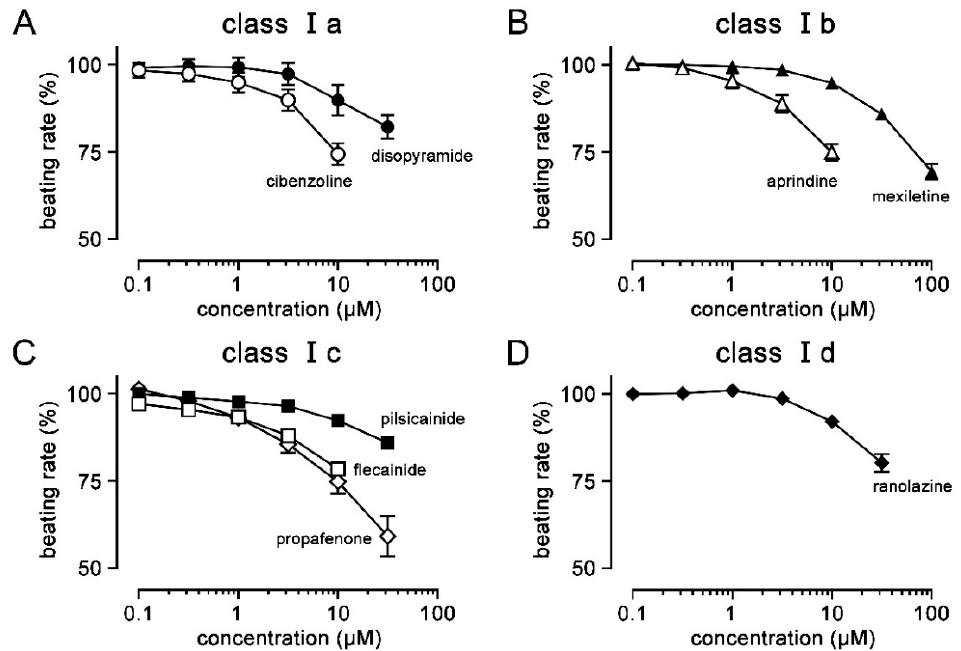
Figure 2. Negative chronotropic effects of Class I antiarrhythmic drugs. The effects of drugs belonging to the Vaughn Williams classification Ia, Ib, Ic, and Id were shown in panels ( A – D ), respectively. The beating rate was expressed as a percentage of the values before application. Symbols and vertical bars indicate the mean ± S.E.M. ( n = 5).